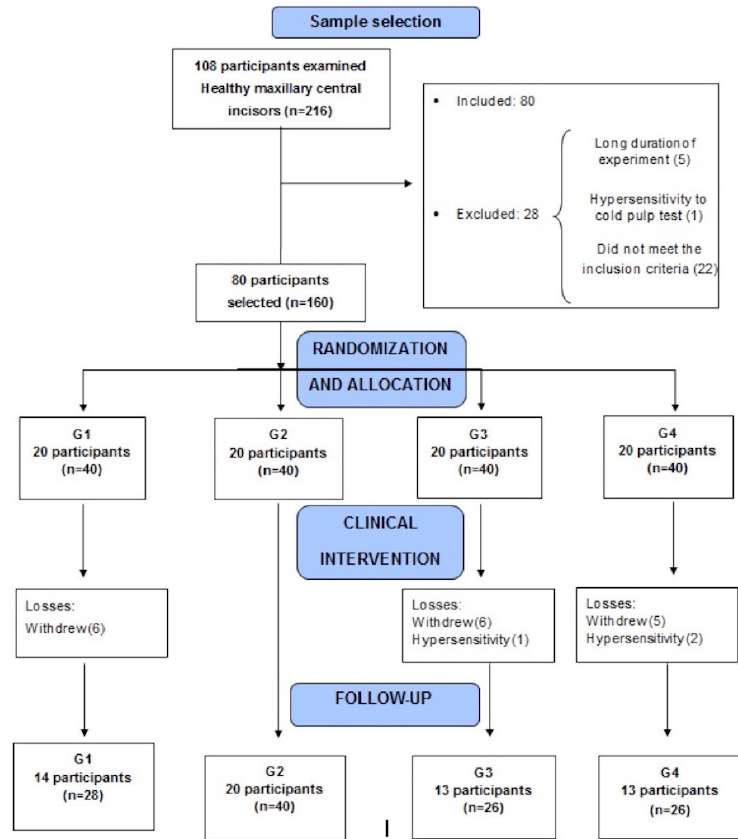
Figure 2- Flow diagram of study